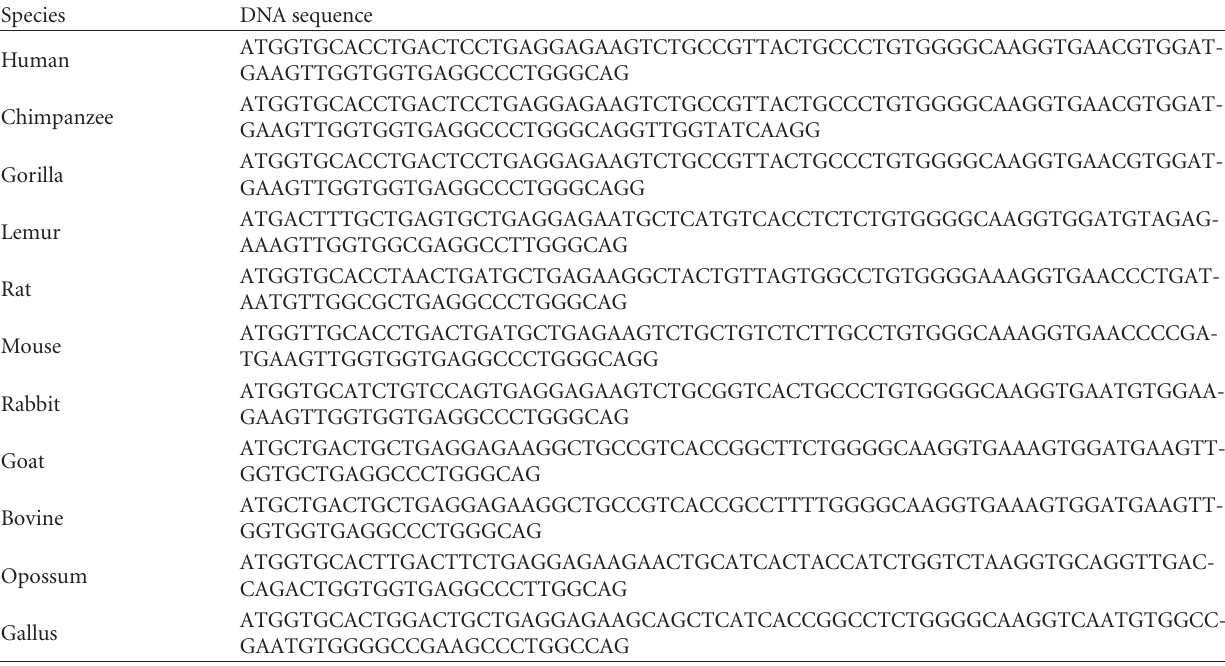
Table 2: The coding sequence of exon-1 of β -globin gene for 11 species.